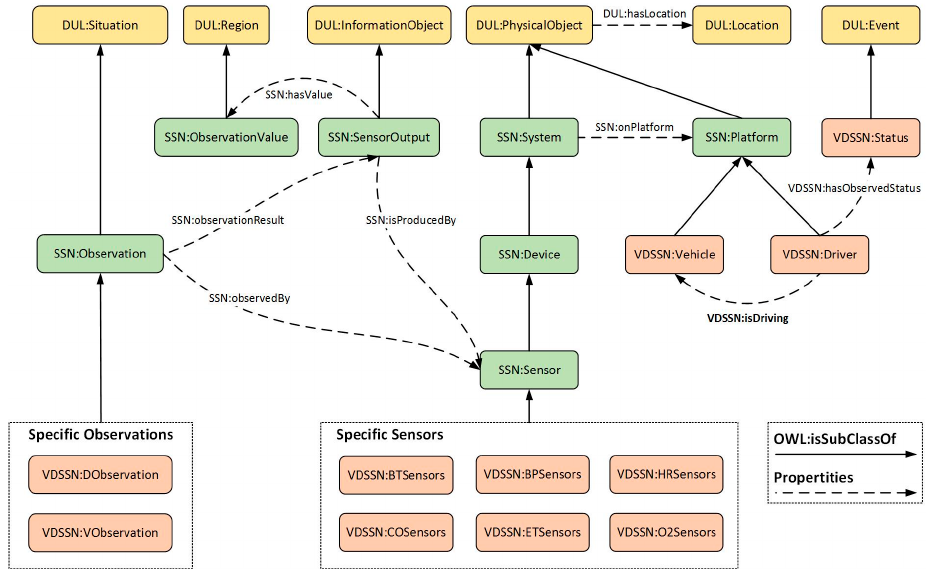
Figure 2. Inheritance relationship among Vehicle-Driver Semantic Sensor Network (VDSSN), SSN and DOLCE Ultra Lite (DUL) ontologies.